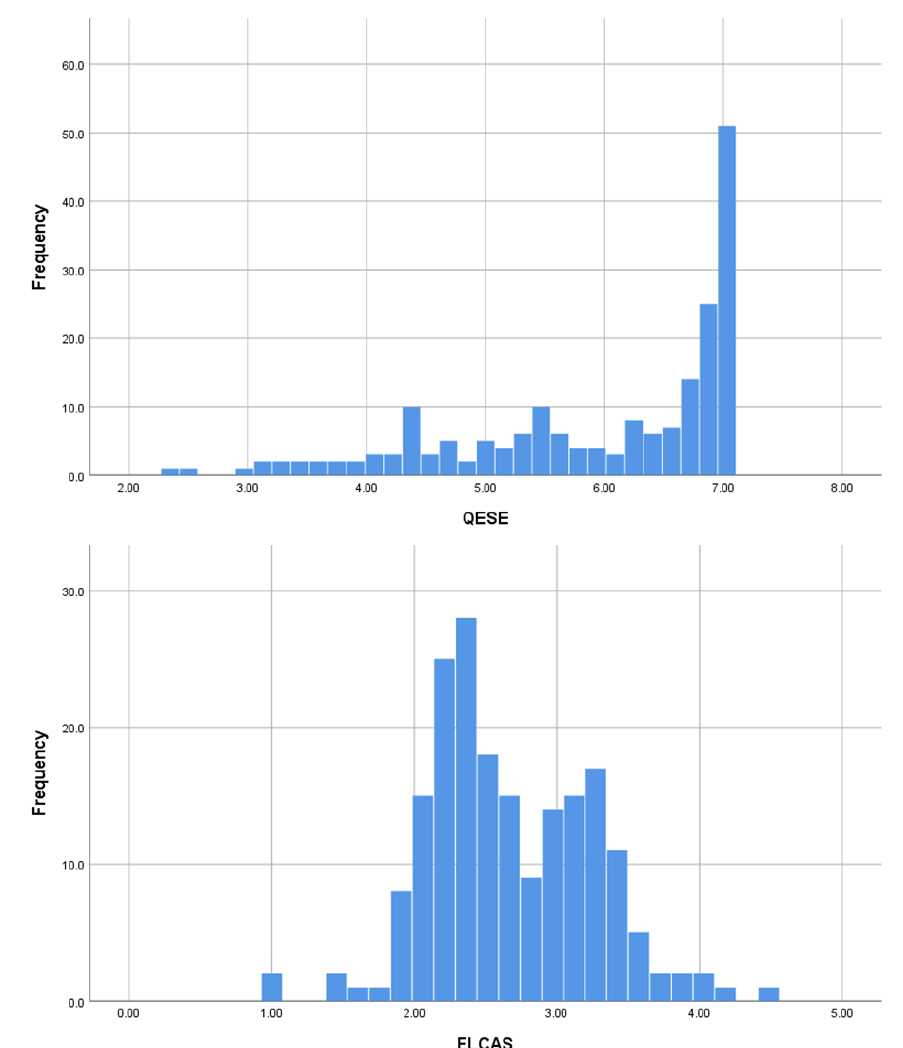
Figure 1. Distribution of scores for the QESE and FLCAS